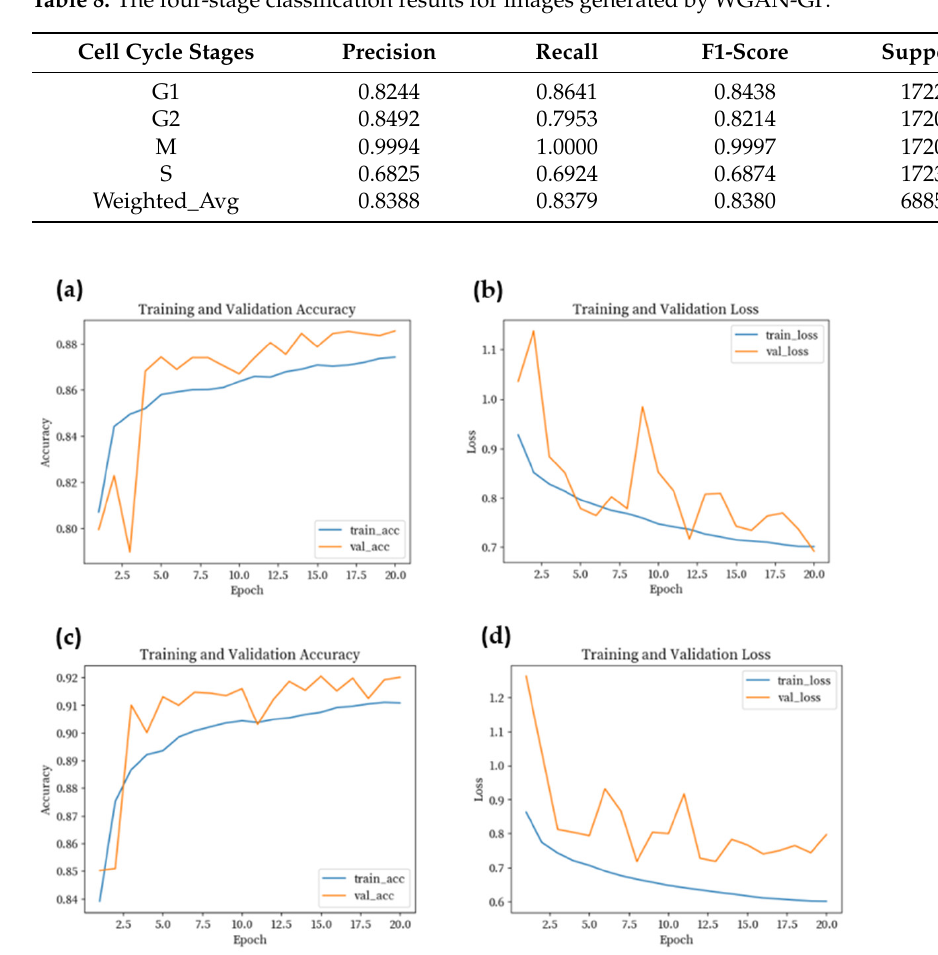
Figure 6. The training and validation accuracy and loss versus the number of training epochs. ( a ) Accuracy of four stages classification for original images; ( b ) loss of four stages classification for original images; ( c ) accuracy of four stages classification for generated images; ( d ) loss of four stages classification for generated images.